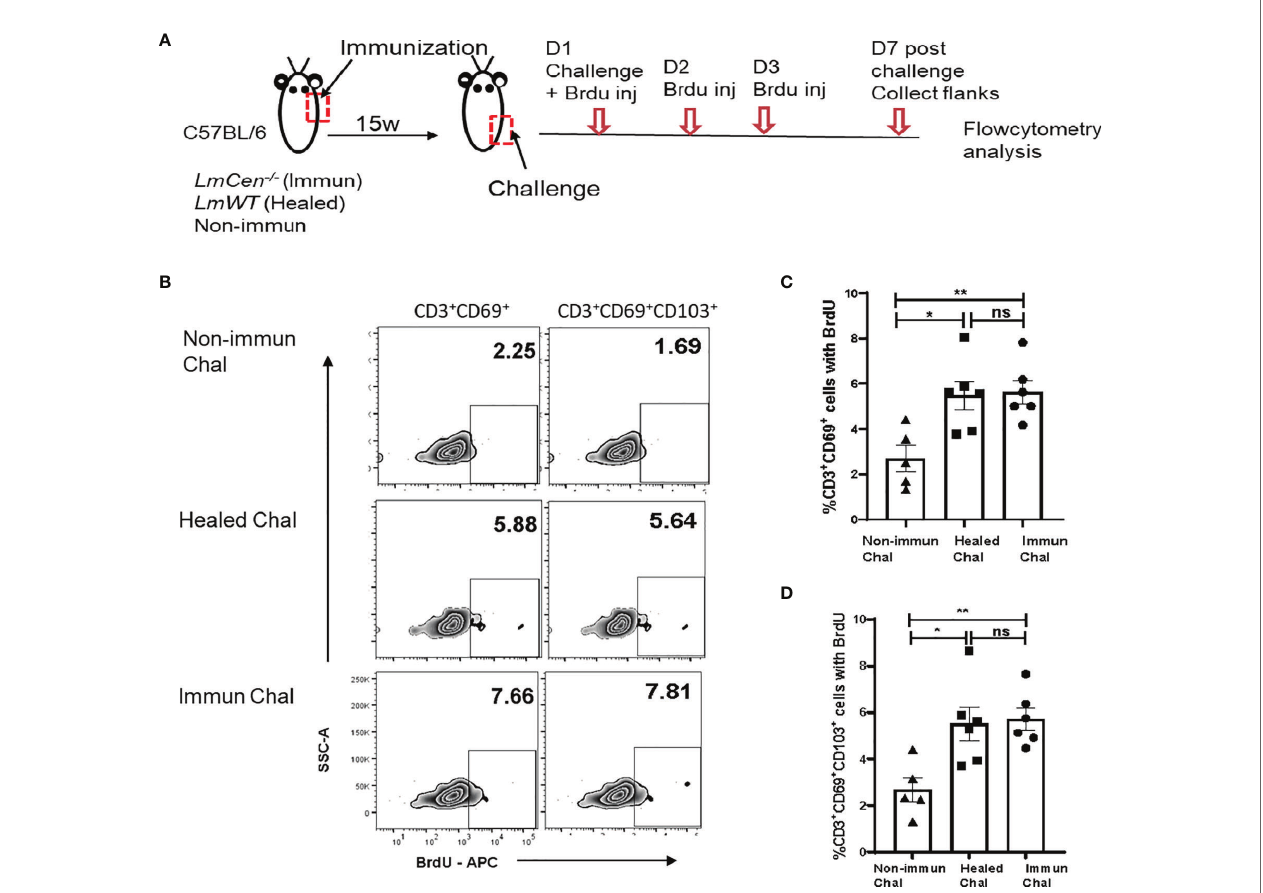
FIGURE 4 | TRM cells from LmCen -/ – immunized mice proliferate locally following challenge with virulent LmWT parasites. Fifteen - week (15w) immunized and healed mice were challenged with LmWT parasites and injected with BrdU, as described in the Materials and Methods . Mice were euthanized, and fl ank skins were collected 7 days post-challenge and analyzed for BrdU-positive cells. (A) Schematic plan of the experiment. (B) Representative BrdU staining on skin CD69 + (single positive) and CD69 + CD103 + (double positive) TRM cells 7 days post- LmWT challenge. The numbers represent the percentage of gated population as a ratio of total parent population (CD69 + or CD69 + CD103 + , C, D , respectively). Panels (C, D) show the proportion of skin CD69 + and CD69 + CD103 + TRM cells, respectively, with incorporated BrdU in the Non-immunized, Healed, and Immunized mice 7 days post- LmWT challenge. *p < 0.02, **p = 0.005, ns = not signi fi cant. Data shown are combined results from two independent experiments, n = 5 – 6. Results are mean ± SEM; statistical analysis was performed by two-tailed unpaired t-test. D, Days; Chal, Challenged; inj,